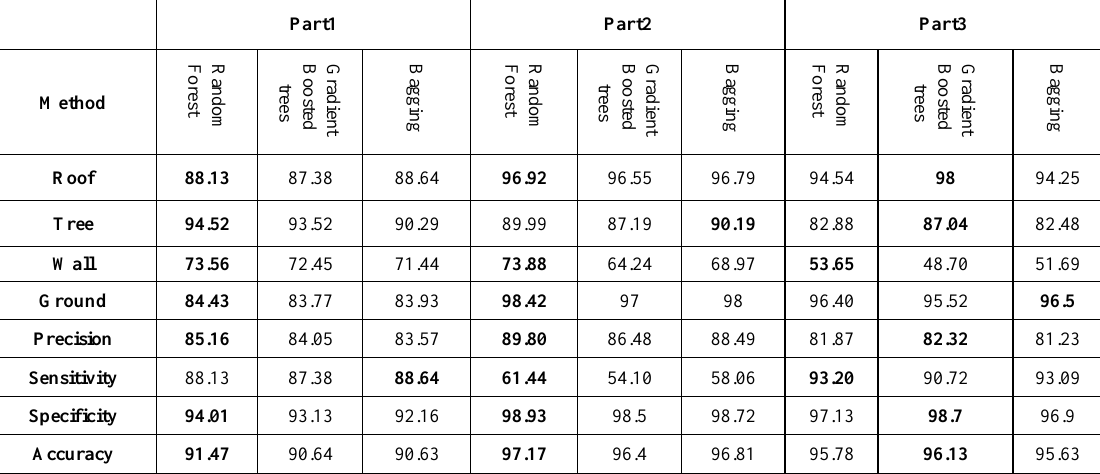
Table 4 Experimental results of the classification methods